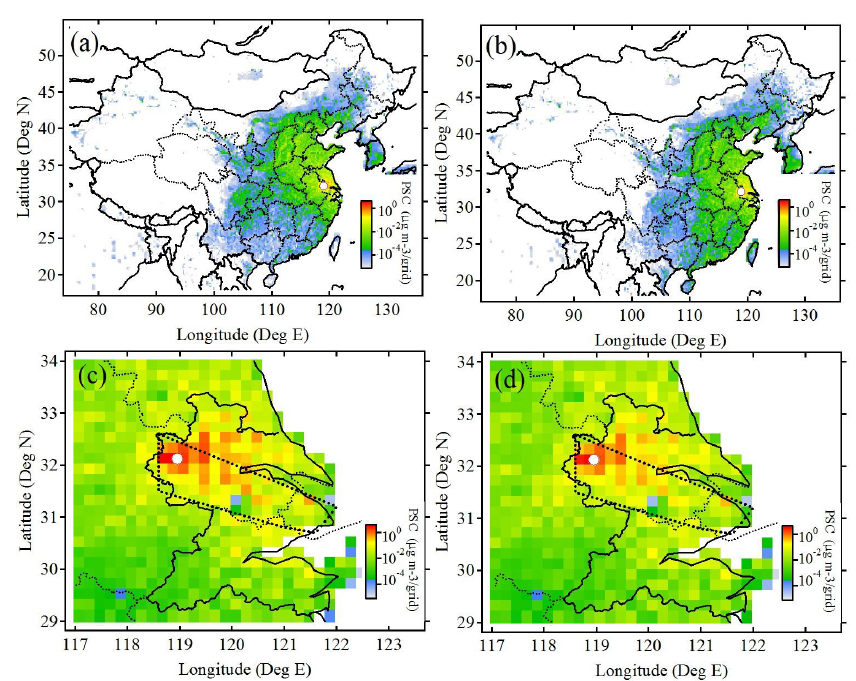
Figure 12 . Same as Fig. 11 but for days with PM 2.5 exceedances and non-episode days, 3 respectively. 4